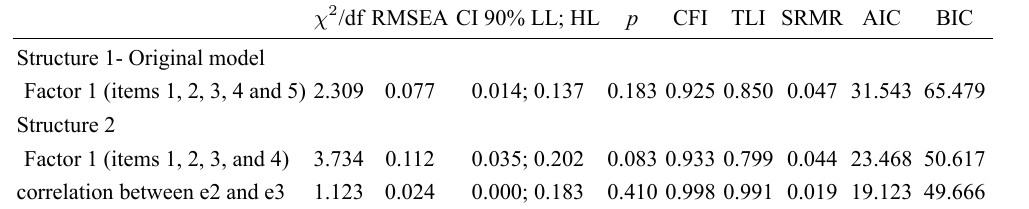
Table 4. Factorial structure for EFA and model fit indices from the CFA of the Portuguese version of PCIBS (N = 220).